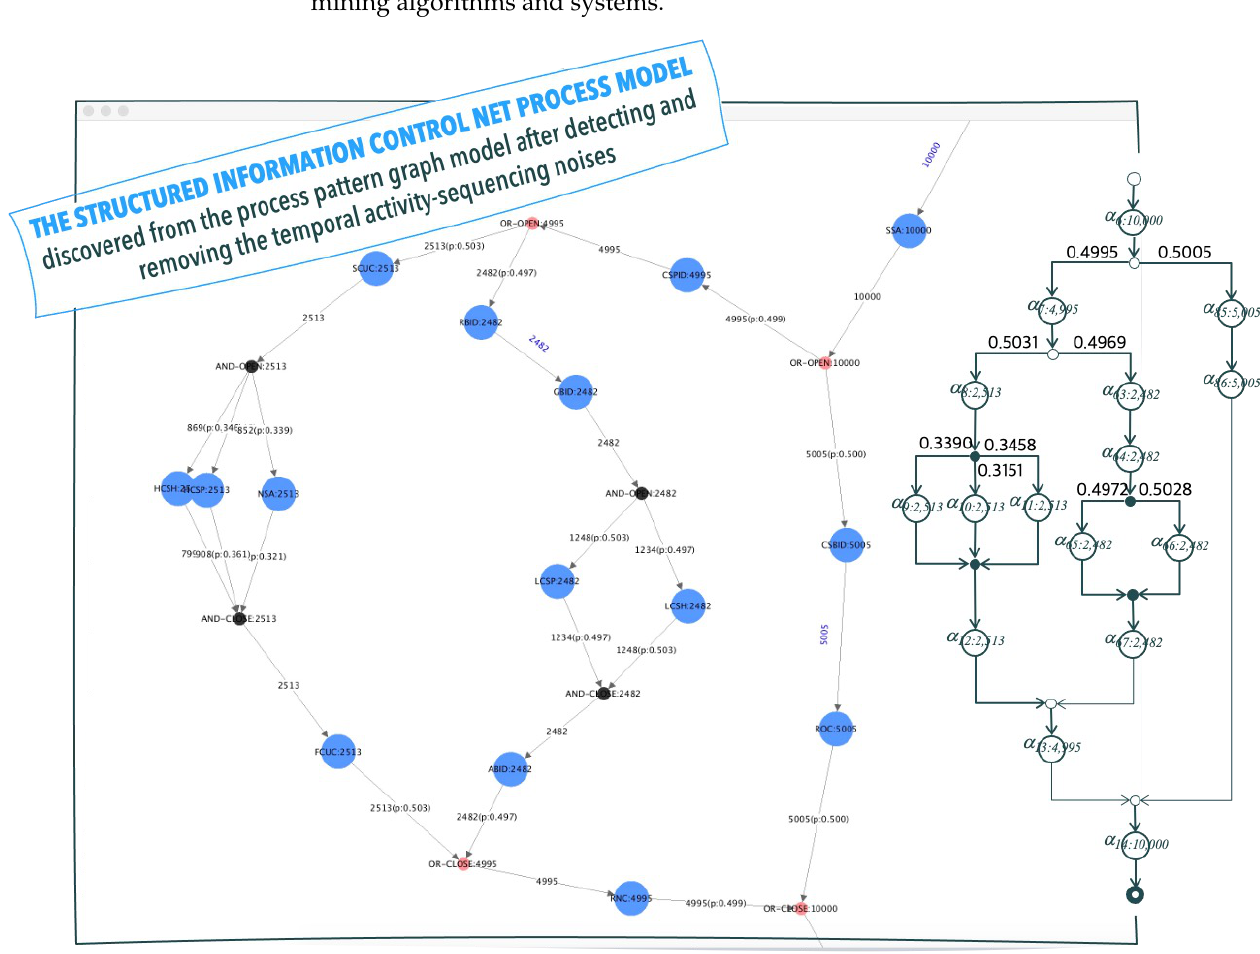
Figure 4. Effectiveness of the noise detection and removal: The SICN-based process model discovered from the process pattern graph